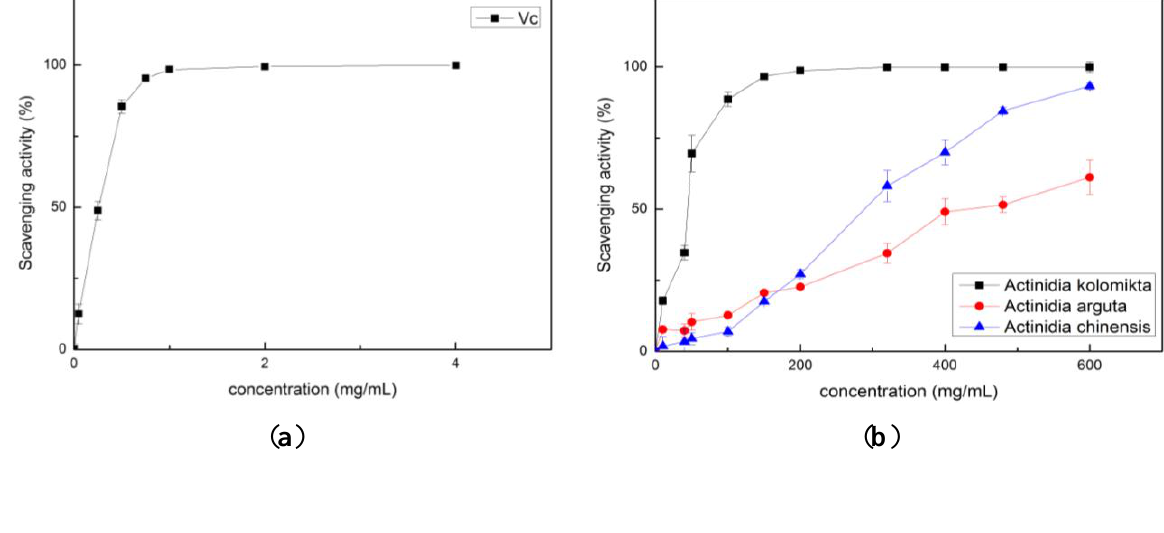
Figure 3. ( a ) The O 2− scavenging activity of vitamin C; ( b ) The O 2− scavenging activity of three Actinidia ethanol